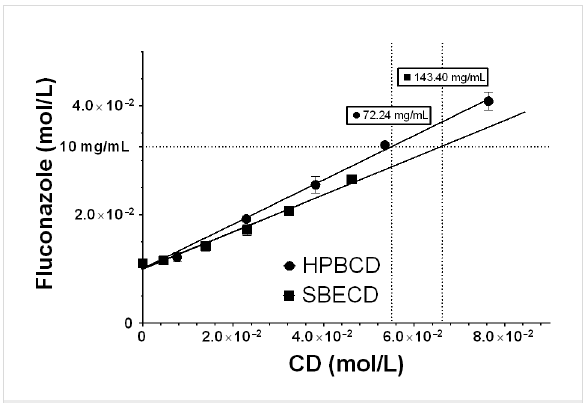
Figure 1: Phase solubility diagrams for fluconazole obtained with β -cyclodextrin derivatives at 25 °C in water (mean ± SD, n = 6). The dotted lines indicate the necessary CD concentration required to solu- bilize 10 mg/mL of